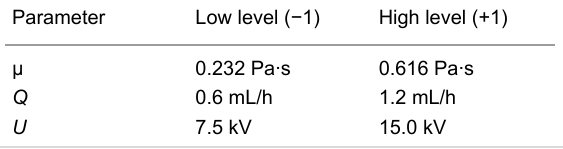
Table 2: Process variables selected for the factorial analysis for fiber diameter.